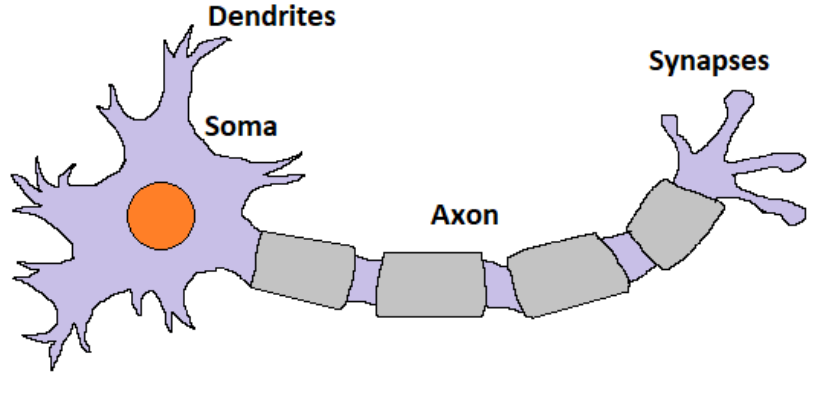
Figure 1. Biological neuron’s